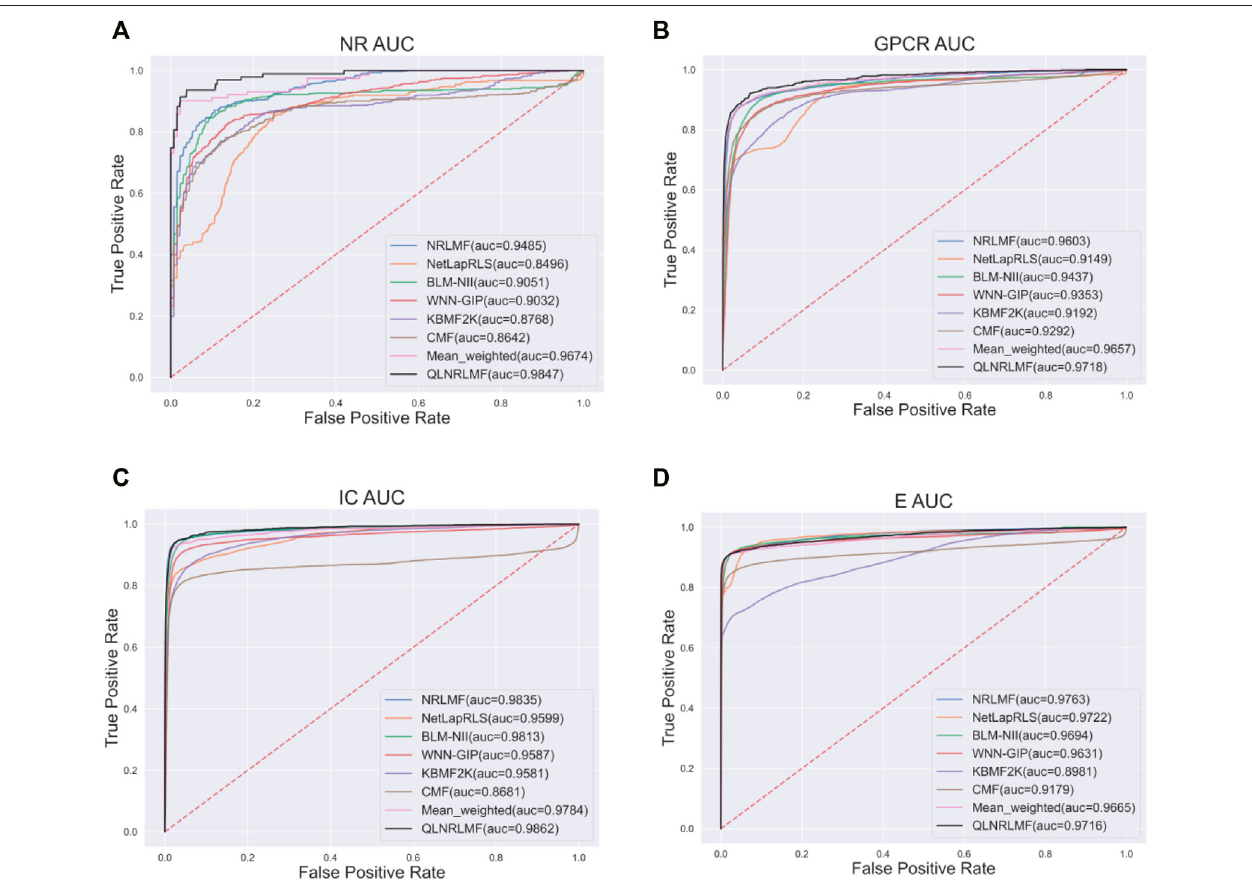
FIGURE 4 | The AUC of QLNRLMF and Other Methods on Benchmark Datasets. (A) The AUC of QLNRLMF and Other Methods on NR Dataset. (B) The AUC of QLNRLMF and Other Methods on GPCR Dataset. (C) The AUC of QLNRLMF and Other Methods on IC Dataset. (D) The AUC of QLNRLMF and Other Methods on E